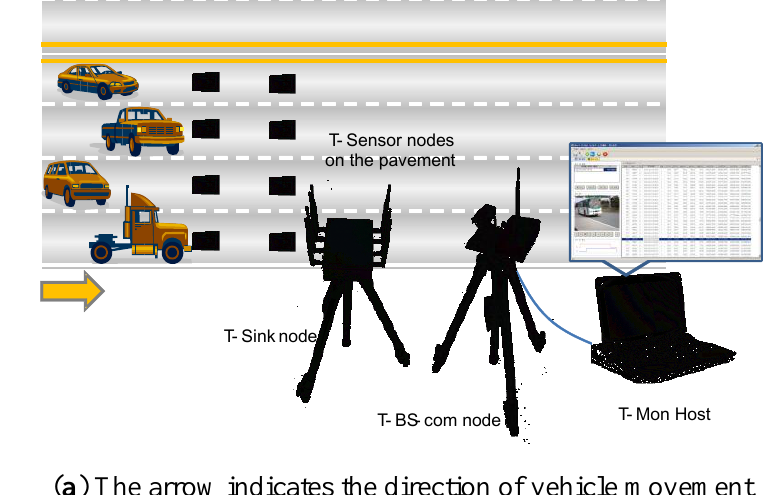
( a ) The arrow indicates the direction of vehicle movement